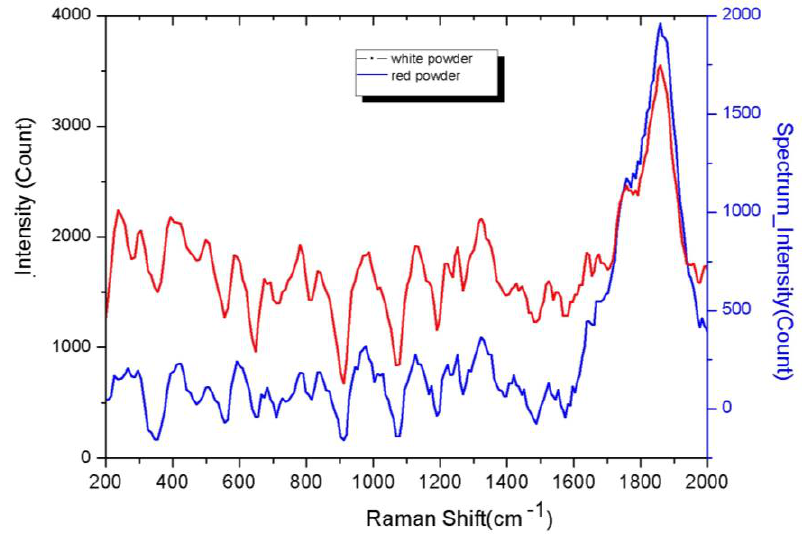
Figure 12. Raman spectra of white powder (blue line) and red ceramic (red line).